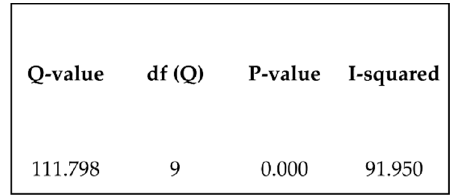
Figure 3. Heterogeneity test.